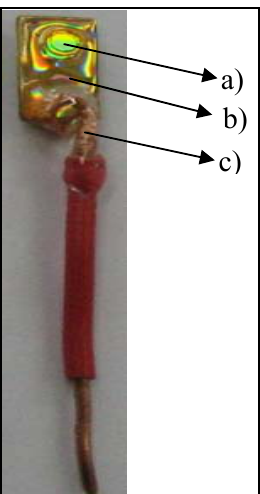
Figure 2 . Gold electrode made in the laboratory: a) uncovered gold surface; electroactive surface; b) epoxy resin (covers the whole electrode with the exception of its active surface; c) insulated copper wire of approximately 0.3 cm in